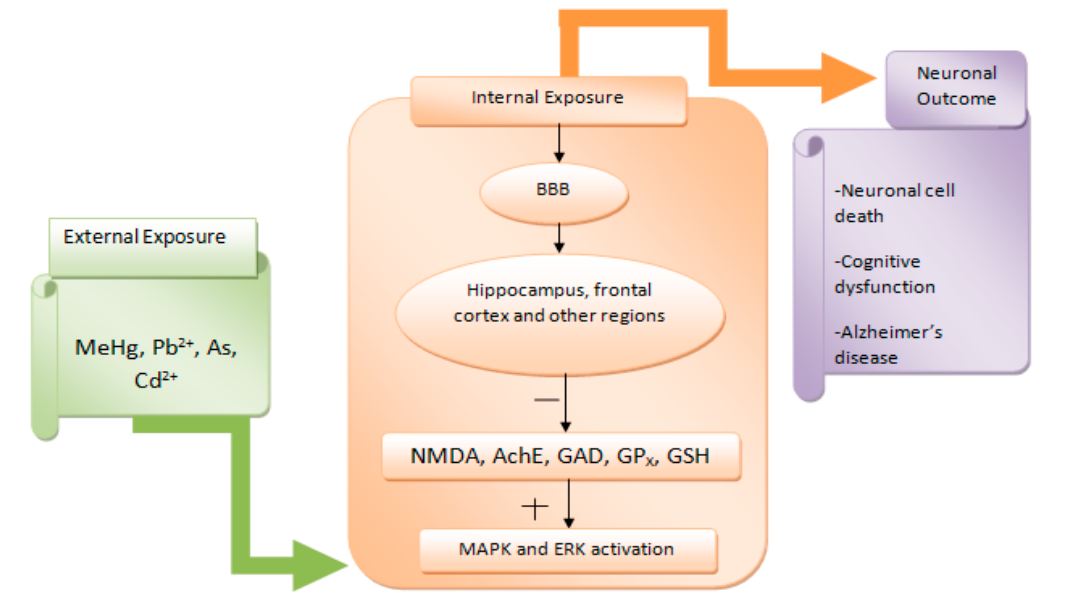
Figure 6. A conceptual framework of metal mixture exposure, mode of action, and disease outcome in the brain, the - sign indicates inhibition of cellular elements and the + sign rising apoptotic factors.